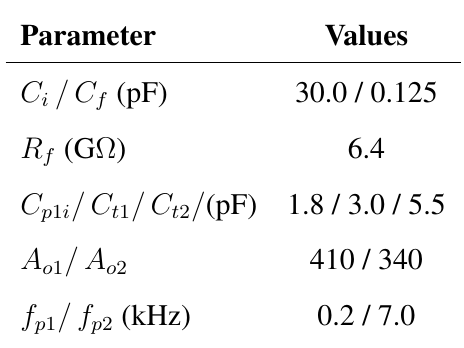
Table 2. Parameters in a typical configuration of the FCCFN